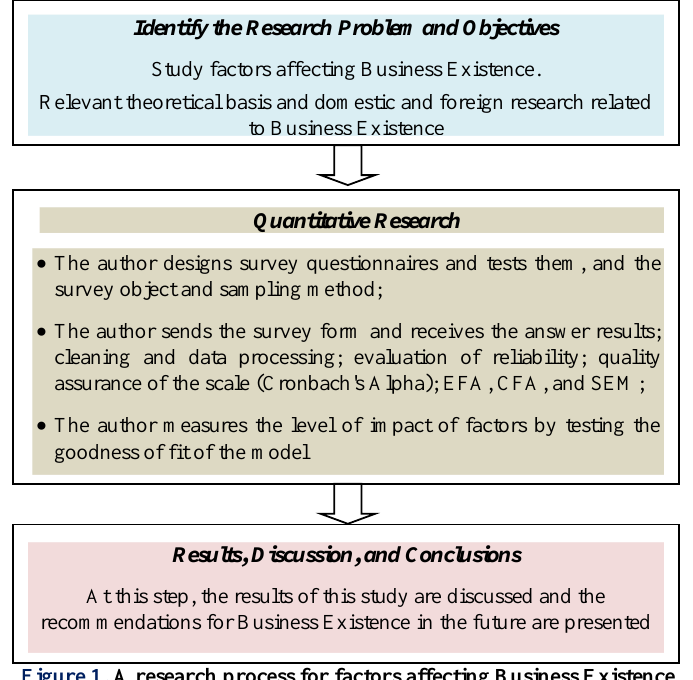
Figure 1. A research process for factors affecting Business Existence